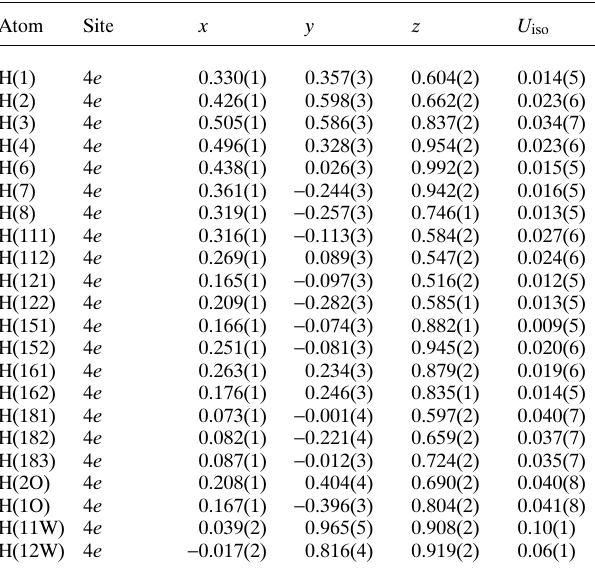
Table 2. Atomic coordinates and displacement parameters (in Å 2 )